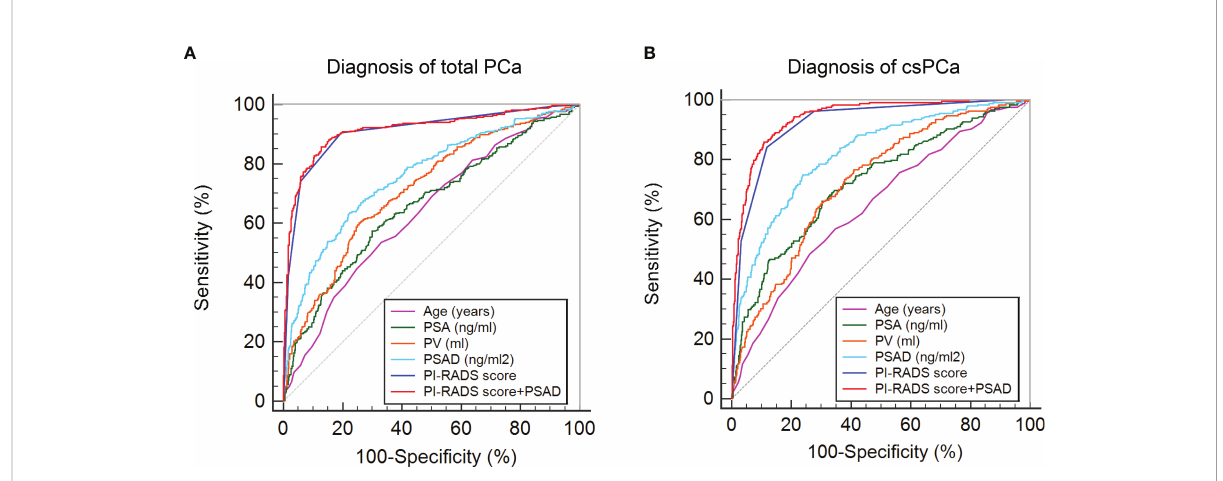
FIGURE 2 ROC curves of clinical variables and combined PI-RADS score with PSAD for the diagnosis of PCa: (A) ROC curves for the diagnosis of total PCa; (B) ROC curves for the diagnosis of